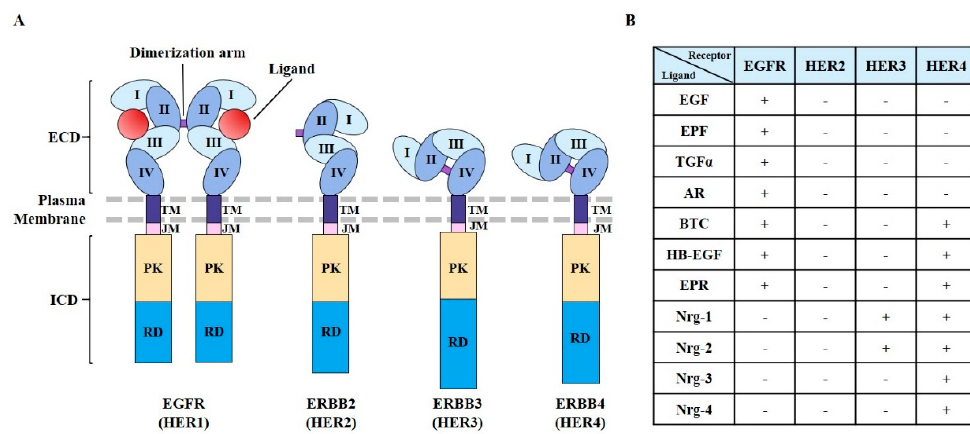
(Figure 2). Exon 19 class I deletions and exon 21 L858R mutations account for 85–90% of TK domain mutations [42]. In its inactive form, the EGFR kinase domain assumes a structure that results in the auto-inhibition of its activity [43]. Mutation at the TK domain of EGFR results in constitutive activation of its kinase activity, and activation of its downstream signaling pathways [44,45].